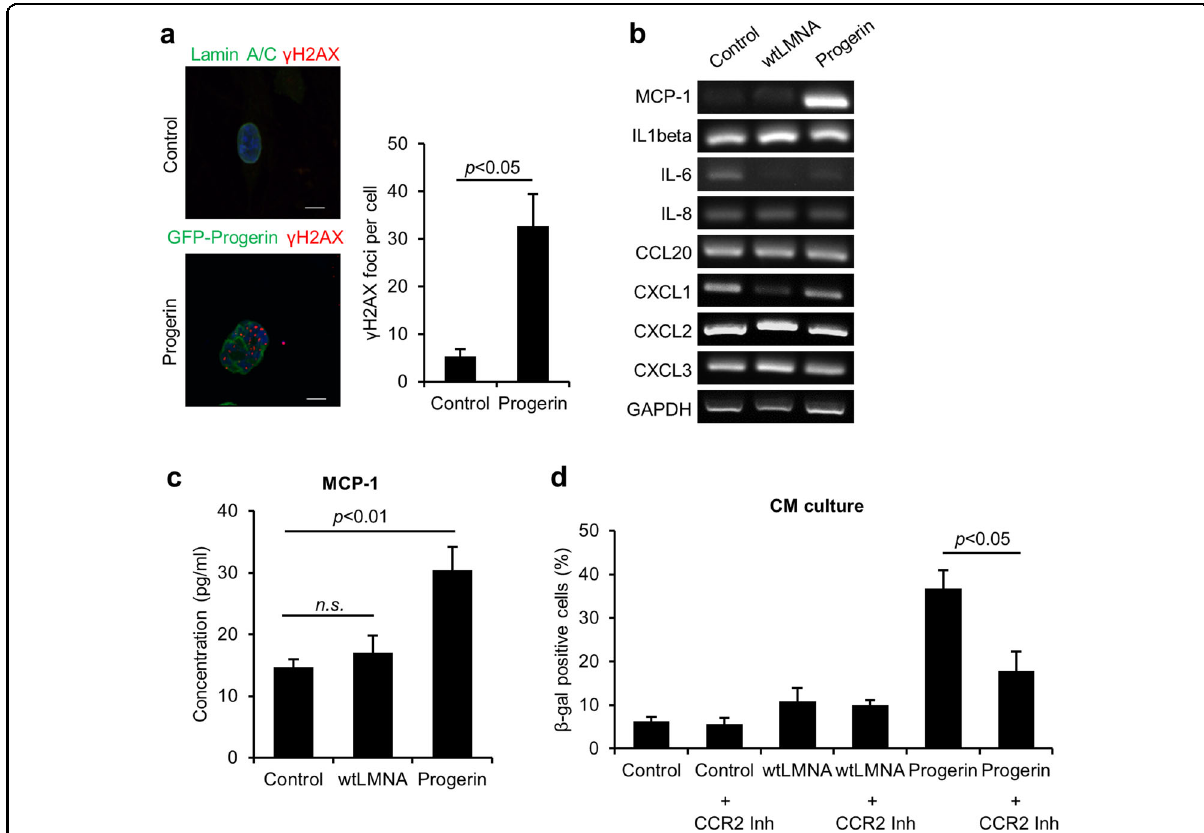
Fig. 2 Progerin-induced DNA damage signaling correlates with MCP-1 expression. a (Left) Representative images of immuno fl uorescence staining of γ -H2AX-positive cells after transduction of GFP-progerin in hMSCs. (Right) Quanti fi cation of γ -H2AX foci per cell ( n = 30). Scale bar = 10 μ m. b – d hMSCs were infected with retrovirus expressing GFP-wt-LMNA, GFP-progerin or empty vector, selected and cultured for 7 days. b PCR analysis was performed to evaluate cytokine expression in control, wt-LMNA, and progerin-expressing hMSCs. c CM was obtained from control, wt- LMNA, and progerin-expressing hMSCs. The secretion level of MCP-1 was analyzed in the CM of each group using ELISA. d Non-senescent hMSCs were cultured with the indicated CM in the presence of CCR2 inhibitor (RS 102895, 100 nM) for 4 days. After the CM culture, SA- β -gal staining was performed to analyze the ratio of senescent cells. Error bars represent means ± s.d. from three separate experiments. n.s.: not signi fi cant. Student ’ s t - test was used for the statistical